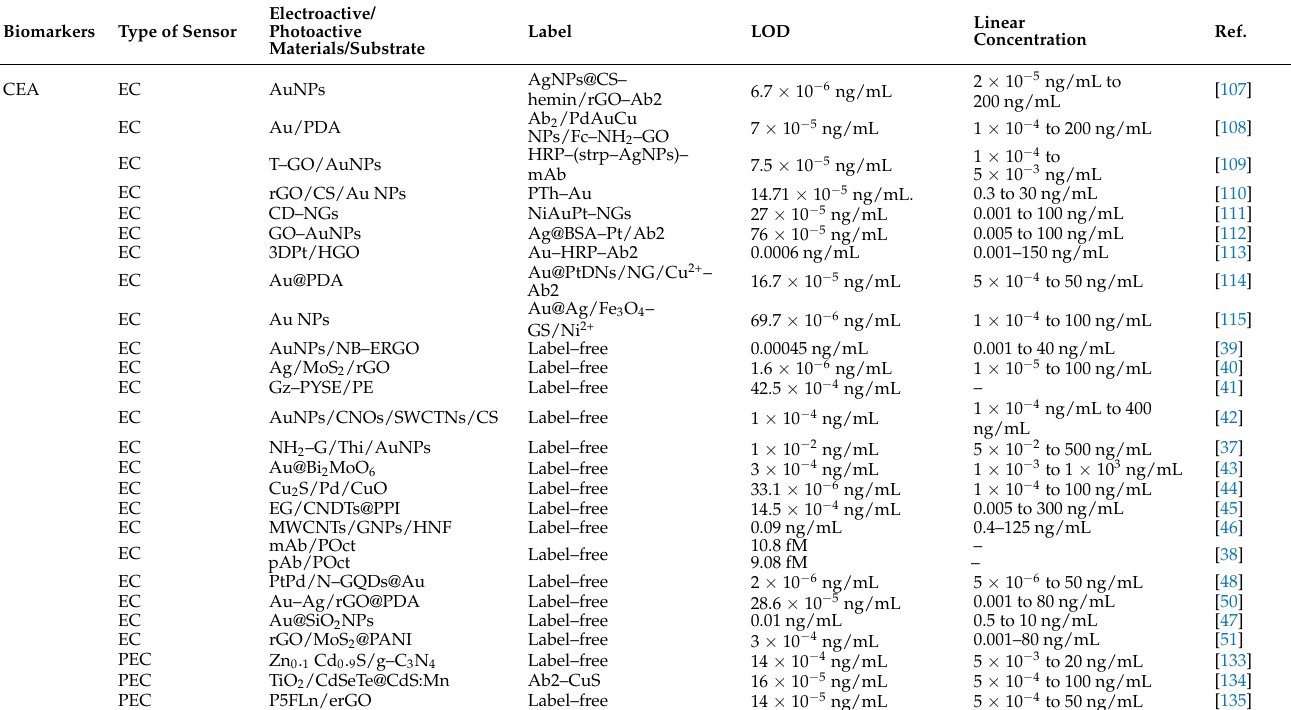
Table 1. Analytical performance of various electrochemical and photoelectrochemical immunosensors in the detection of major ovarian cancer